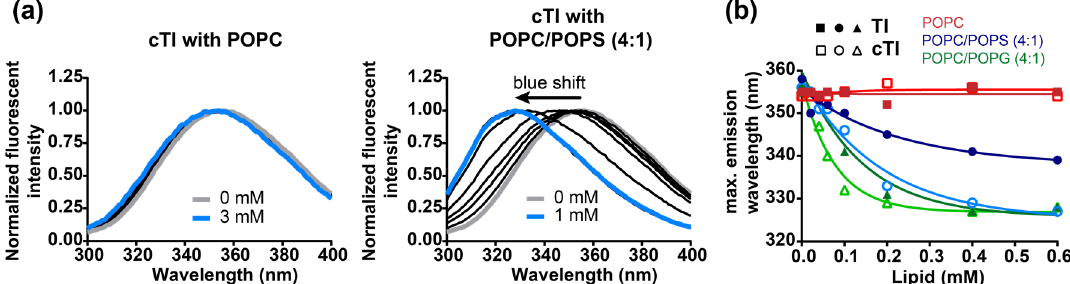
Figure 5. The partitioning of the 12.5 µ M of tachyplesin I–III (TI-TIII) and cyclic analogues (cTI-cTIII) into lipid membranes. ( a ) Normalized fluorescence emission spectra of cTI in aqueous solution (grey) and upon titration with LUVs composed of POPC (1-palmitoyl-2-oleoyl-sn-glycero-3-phosphocholine; up to 3 mM) or of POPC / POPS (1-palmitoyl-2-oleoyl-sn-glycero-3-phosphoserine; 4:1) up to 1 mM). Fluorescence emission spectra were obtained with excitation at 280 nm ( b ) Wavelength at which TI (solid symbol) and cTI (open symbol) have their maximum fluorescence emission in buffer and with increasing concentrations of LUVs composed of different lipid mixtures (POPC: red; POPC/POPS (4:1): blue; POPC/POPG (1-palmitoyl-2-oleoyl-sn-glycero-3- phosphoglycerol; 4:1): green). Table 7. Shift in the fluorescence emission maximum wavelength of tachyplesin I–III (TI-TIII) and cyclic analogues (cTI-cTIII) in buffer and in the presence of model membranes.